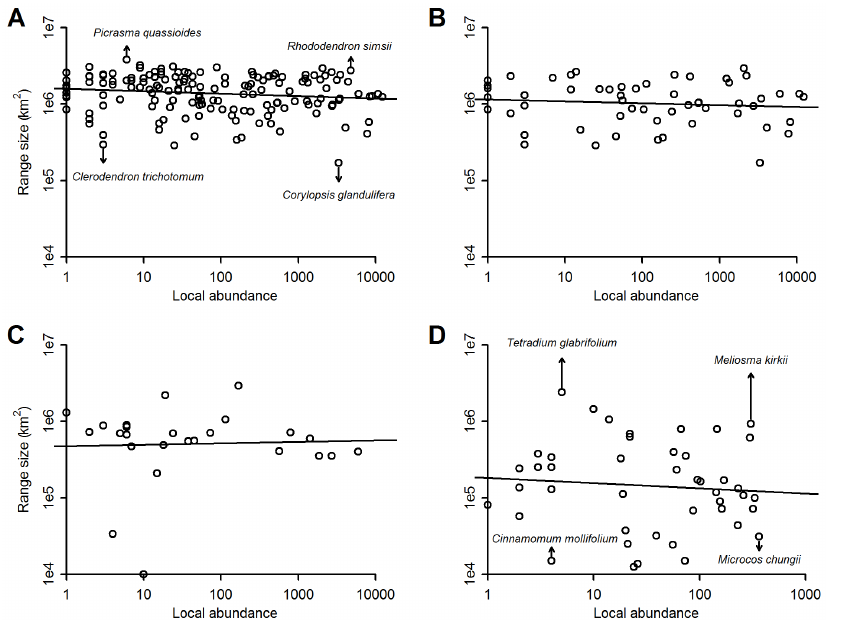
Figure 5. Relationship between range size and local abundance. Panel A shows all species from the Gutianshan plot, and the other panels endemics from Gutianshan (B), Dinghushan (C), and Xishuangbanna (D). The axes were both log 2 -transformed. In each case, only species with $ 20 geo-referenced records were included.